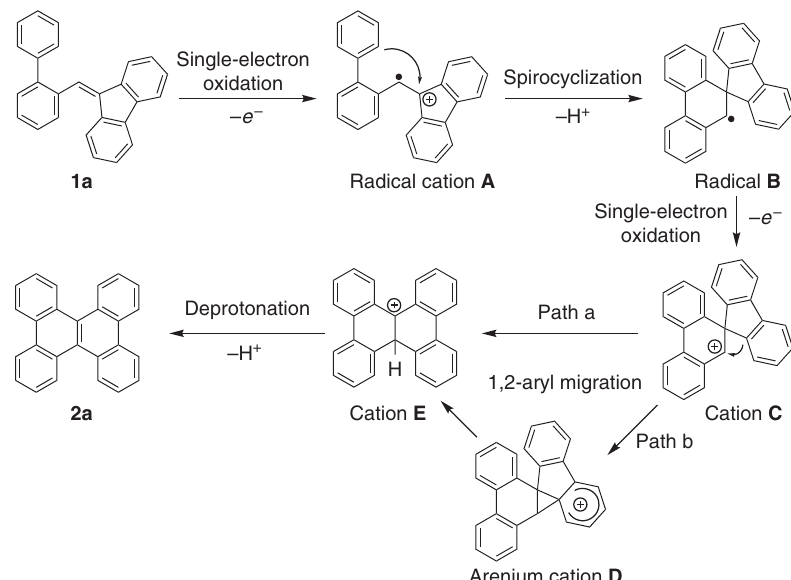
Figure 7 | Proposed tandem reaction mechanism. Initially, the reaction takes place via a single-electron oxidation of the relatively electron-rich alkene moiety of 1a , followed by the intramolecular Friedel-Crafts reaction to form a spirocyclic radical species B , which is further oxidized to give a spirocyclic cation C . The cation C gives rise to the 1,2-aryl migration followed by aromatization to afford the desired dibenzochrysene 2a .